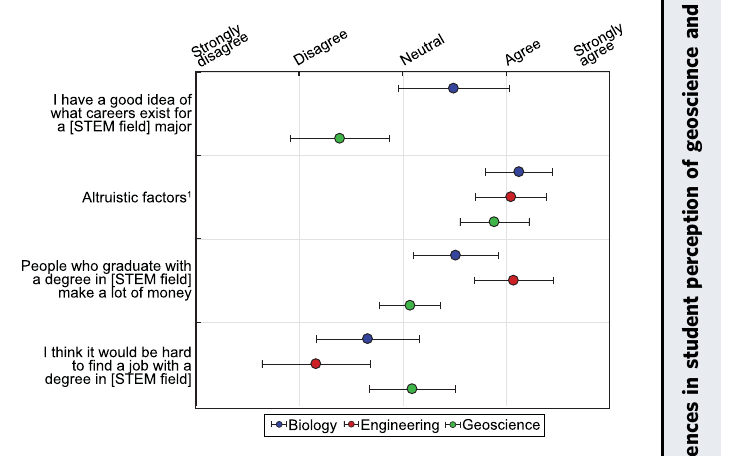
Fig. 3 Perception of the geoscience by survey respondents compared with other STEM fi elds. The points show the average response of the entire survey population. The error bars show the standard deviation of the average response. 1 Altruistic factors include a combination of the two items “ [STEM fi eld] careers offer opportunities to help people and society ” and “ [STEM fi eld] careers offer opportunities to help the environment ”